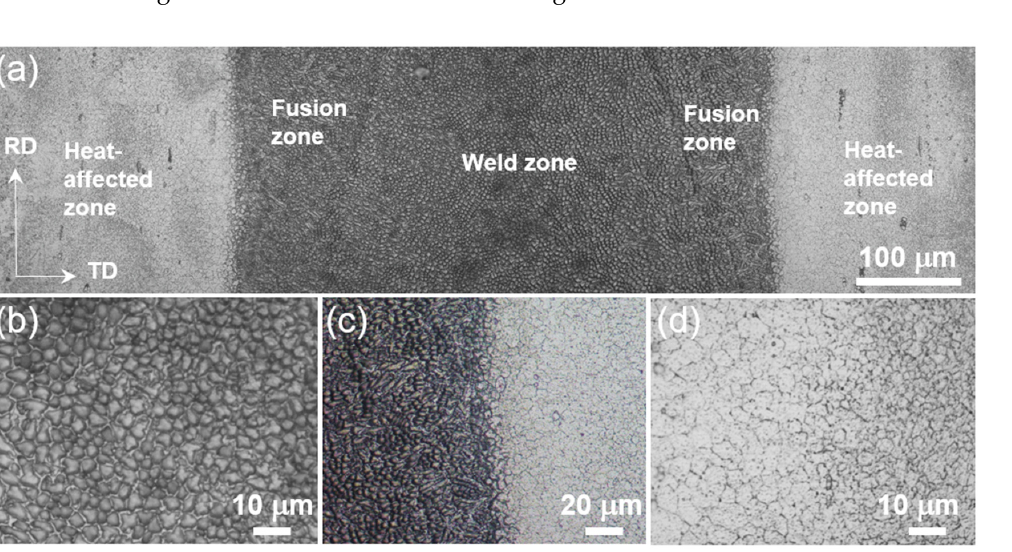
Figure 3. OM diagram showing the microstructure of the HS sample. ( a ) Overall shape of the core weld area; ( b ) shape of the middle weld area; ( c ) shape of the fusion zone at the boundary with the heat affected zone; and ( d ) shape of the heat affected zone.